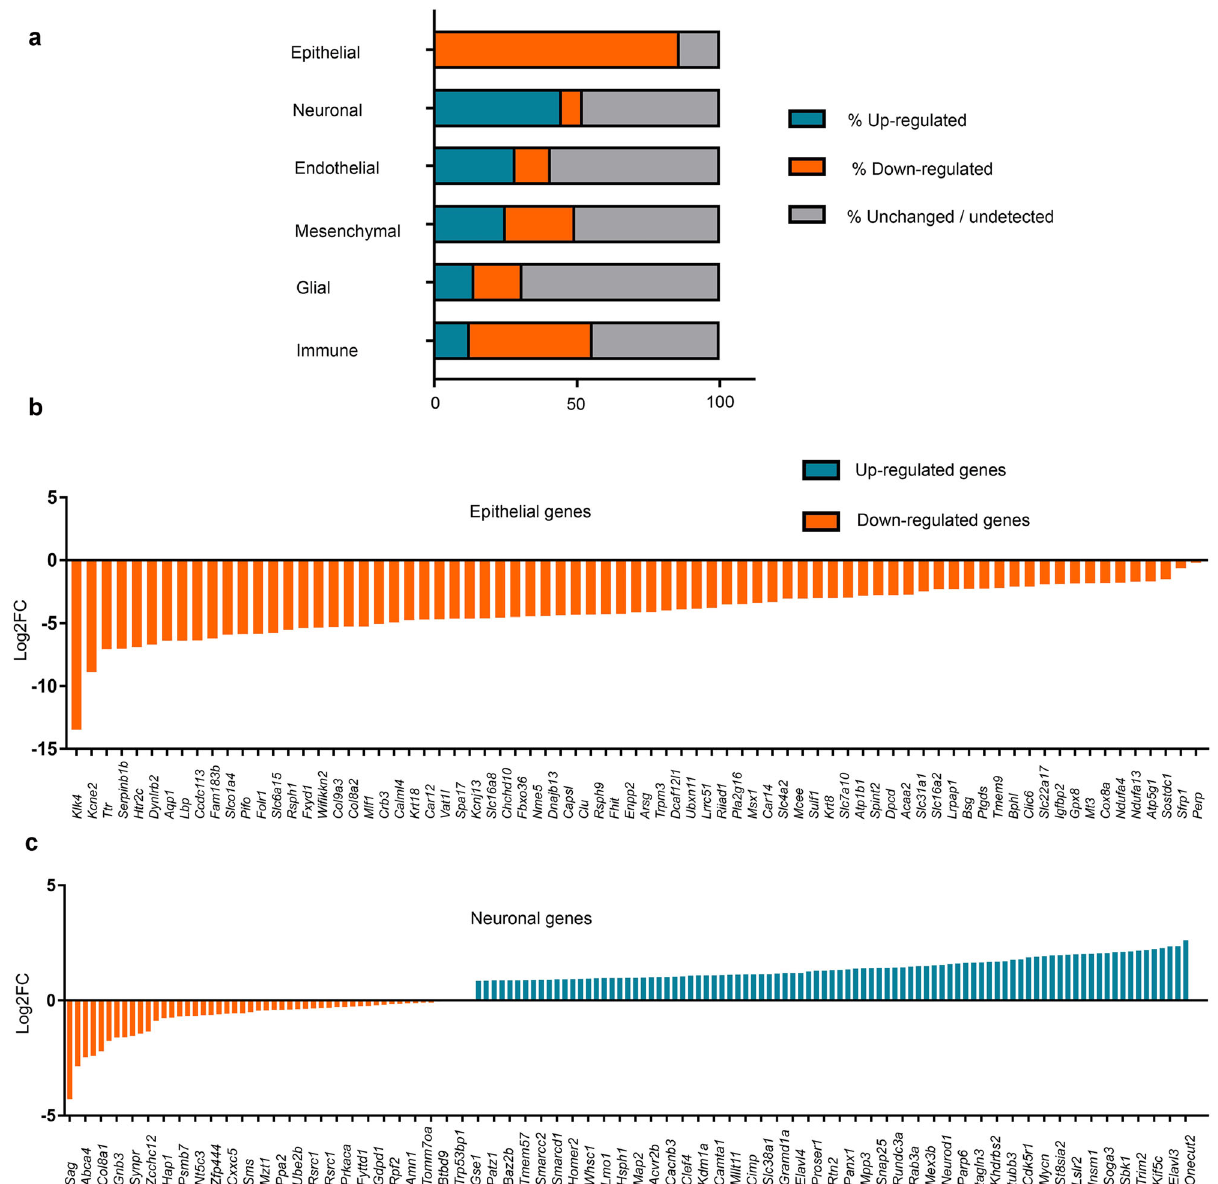
Fig. 8 Cell-type classi fi cation of genes dysregulated upon constitutive activation of β -CATENIN. ( a ) comparison of RNA-seq data from E14.5 Lmx1aCre:: β -catenin GOF ChP with scRNA-seq data from E16.5 ChP (Dani et al., 2021). Genes that were differentially expressed (DE) between the Lmx1aCre:: β -catenin GOF ChP and control ChP (Supplementary data 1) were compared with the genes enriched in Epithelial/Neuronal/Endothelial/ Mesenchymal/Glial/Immune cell groups identi fi ed in Dani et al., 2021. For each cell group, the DE list contained genes that were either upregulated